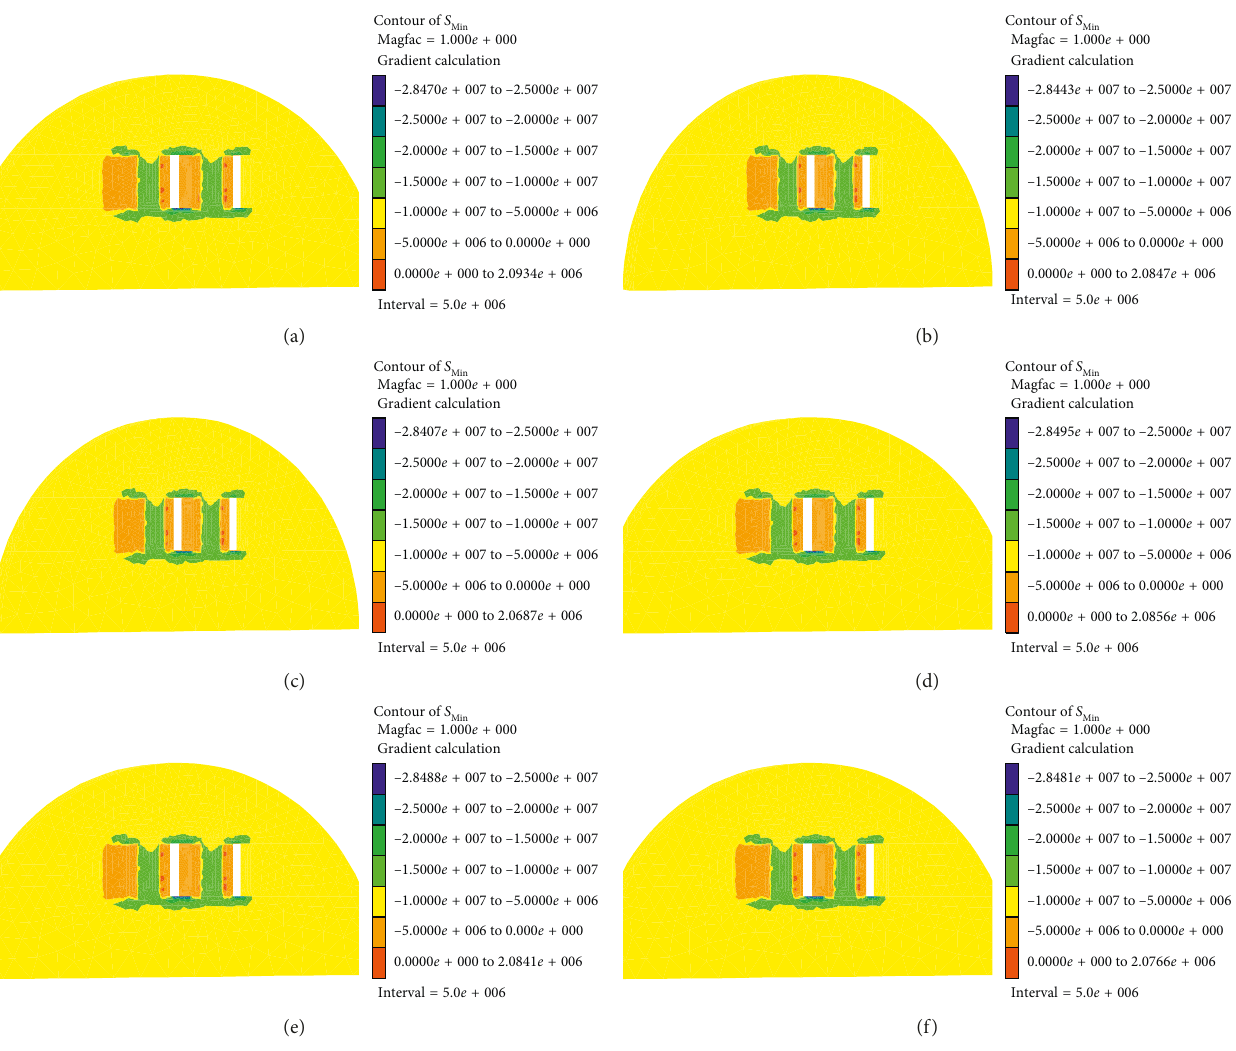
Figure 9: Minor principal stress cloud: (a) cement-sand ratio 1:6, backfill concentration 68%; (b) cement-sand ratio 1:6, backfill concentration 72%; (c) cement-sand ratio 1 :6, backfill concentration 78%; (d) cement-sand ratio 1:8, backfill concentration 68%; (e) cement-sand ratio 1: 8, backfill concentration 72%; (f) cement-sand ratio 1 :8, backfill concentration